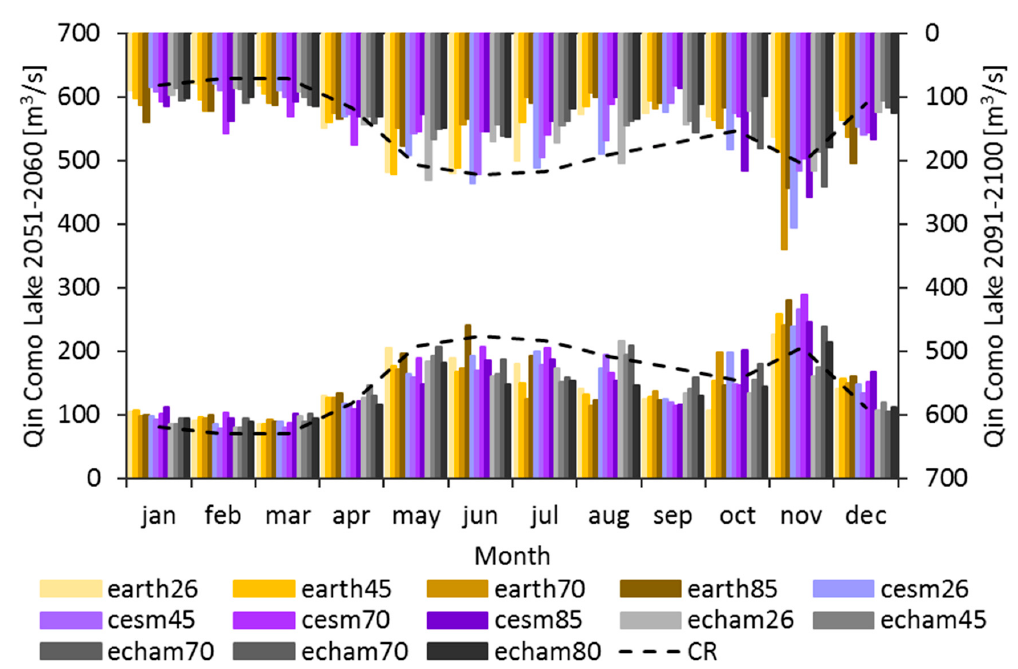
Figure 11. Projected monthly inflow to Lake Como for each SSP and each GCM. 2051–2060 period on the left y axis, 2091–2100 period on the right y axis, upside-down. The black line represents the discharge in the CR period. Table 4. Projected share of flow components for each GCM and each